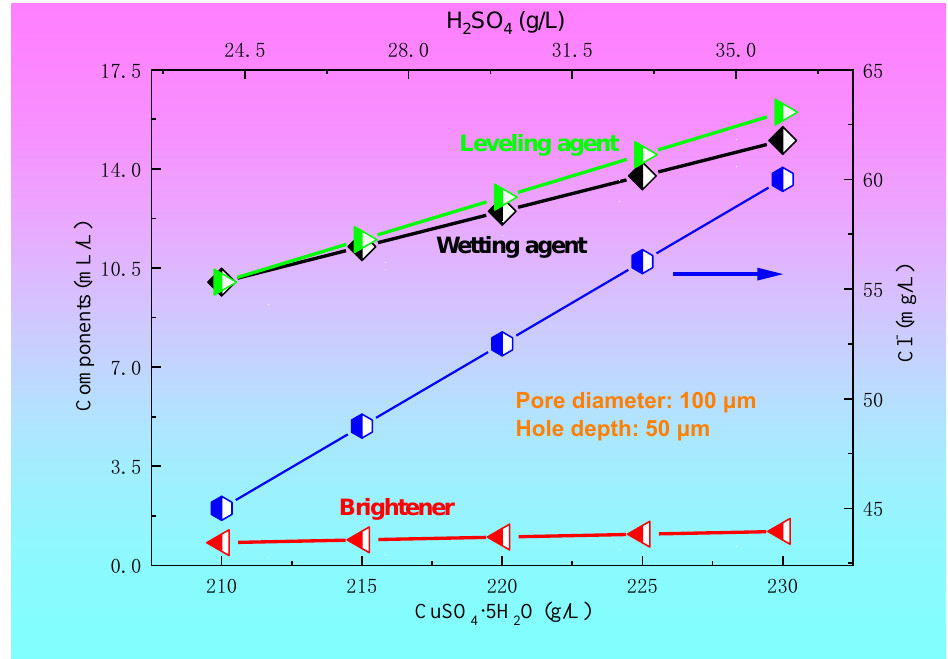
Figure 6. The relationships between the concentration of CuSO 4 · 5H 2 O and H 2 SO 4 and the plating solution formula for the blind hole with a diameter of 100 µ m and a depth of 50 µ m.